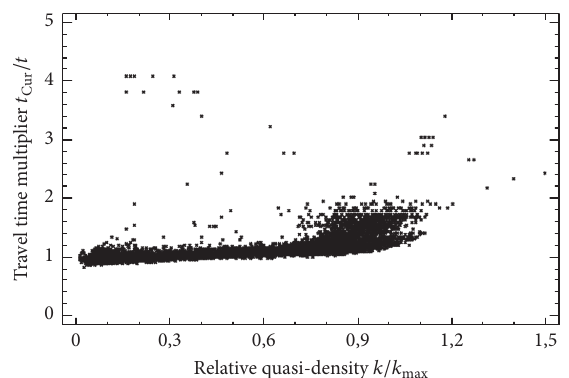
Figure 8: Travel time multiplier against quasi-density